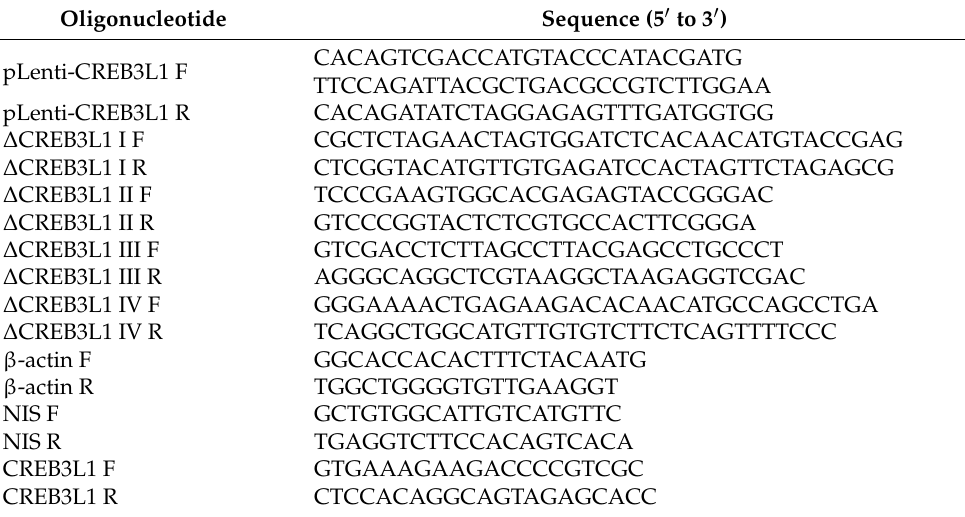
Table 1. Oligonucleotide sequences used in this study. Oligonucleotide Sequence (5 (cid:48) to 3 (cid:48)